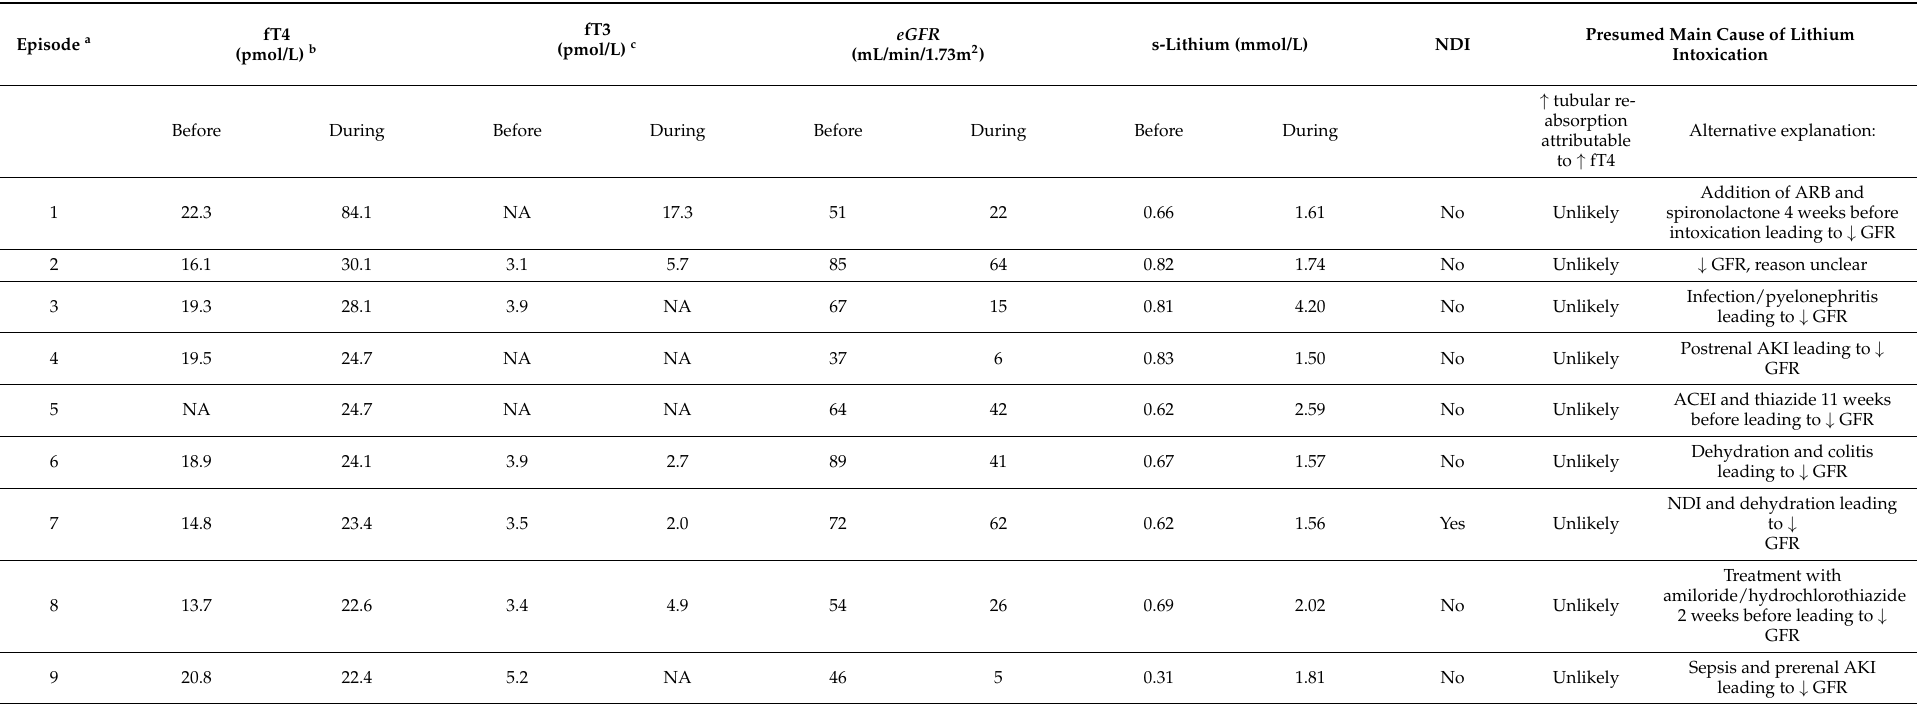
Table 3. Presumed cause of lithium